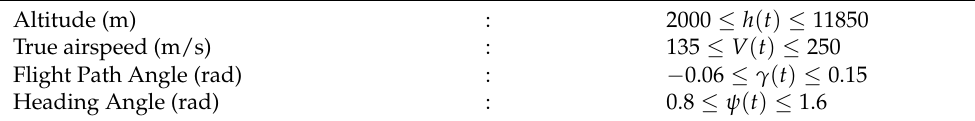
Table 4. Constrains of the flight of the case study.